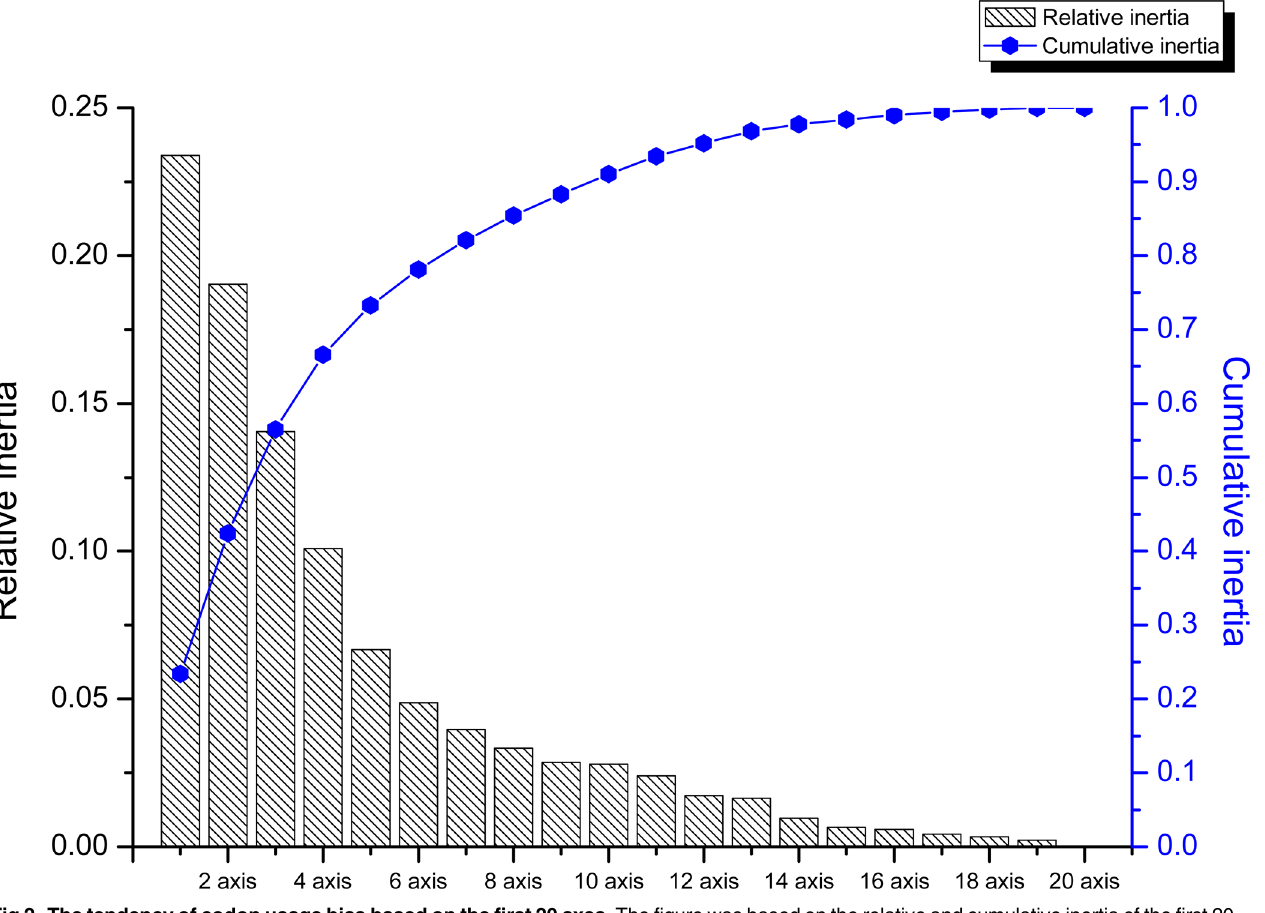
Fig 2. The tendency of codon usage bias based on the first 20 axes. The figure was basedon the relative and cumulative inertia of the first 20 factors, respectively. The relative inertia is represented by the bar chart and the cumulativeinertia is representedby the curve chart.